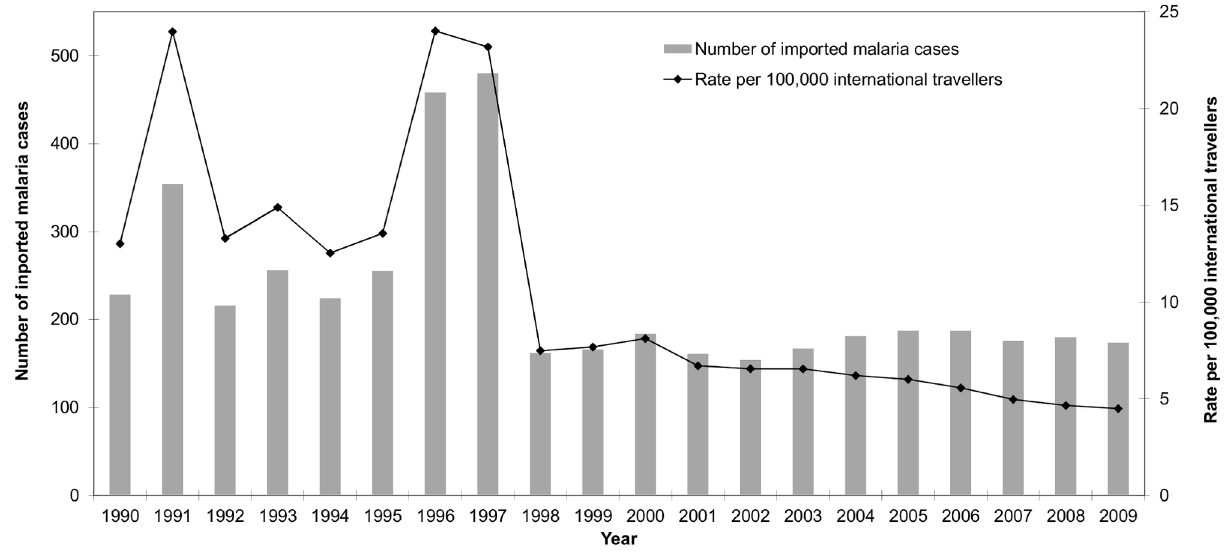
Figure 1. Imported malaria trends in Ontario, Canada (1990–2009) *, †, ‡. *Total number cases for each Plasmodium sp. and percentage of all cases: P. vivax (2305, 50.6%), P. falciparum (1751, 38.6%), Plasmodium sp. (272, 6.0%), P. ovale (142, 3.1%), and P. malariae (81, 1.8%). † Mean rate per 100,000 international travellers (for all Plasmodium species) for study period